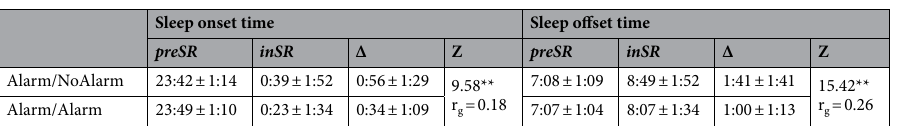
Table 2. Timings (mean ± sd, local time) of falling asleep and waking-up on workdays preSR and inSR by group, Alarm/NoAlarm and Alarm/Alarm. Changes [ inSR- preSR ] are designated by Δ. Mann–Whitney Z scores indicate the differences in Δ values between the groups, r g effect size. **p <